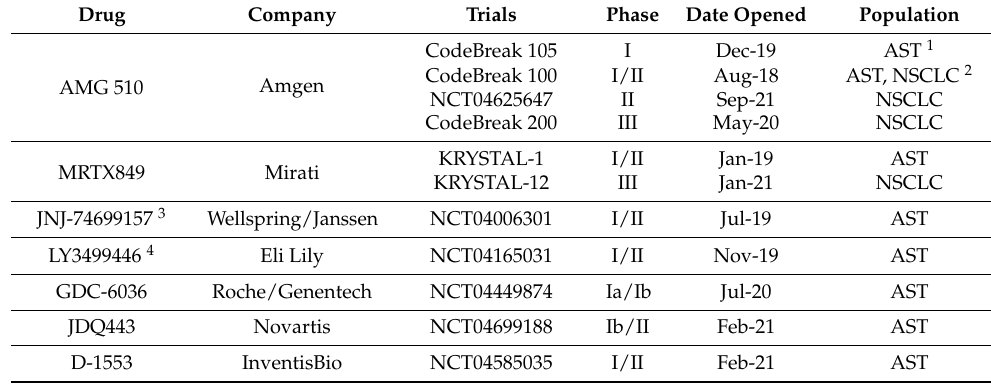
Table 1. KRAS-G12C inhibitor trials with monotherapy arms and pre-clinical